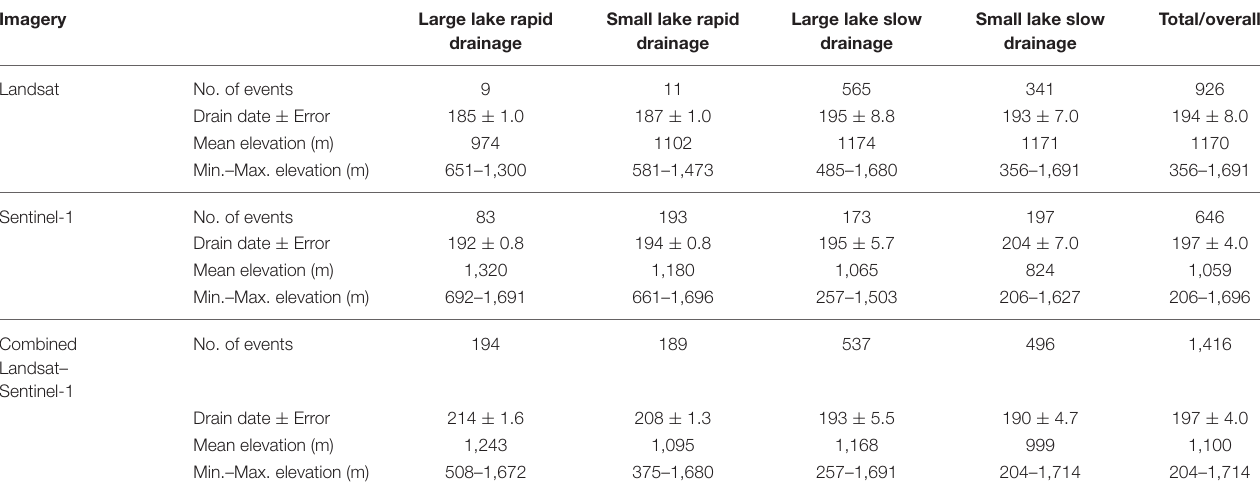
TABLE 2 | Results from the drainage detection algorithm, for the three imagery analyses (Landsat only, Sentinel-1 only, and Landsat–Sentinel-1 combined).